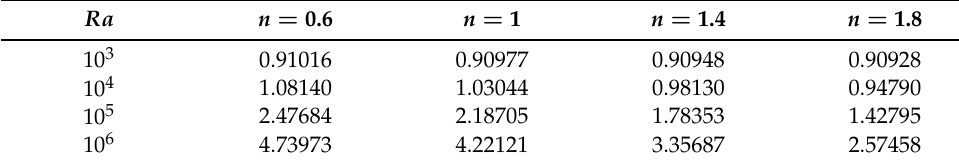
Table 5. The values of the average Nusselt number ( Nu avg ) at the solid-fluid interface.